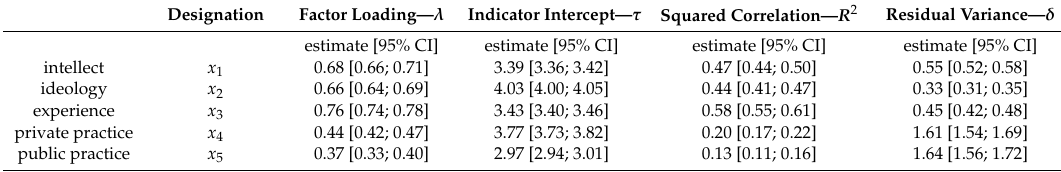
Table A5. Results of the Confirmatory Factor Analysis of the CRS-5 invariance examination.